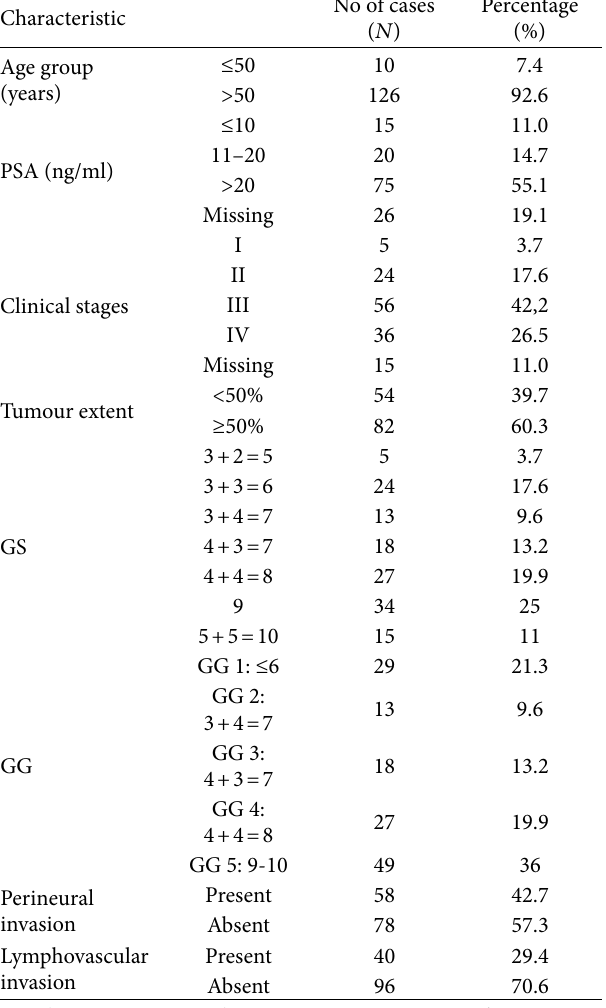
GS: Gleason score, GG: grade grouping, PSA: prostatic-specific antigen.